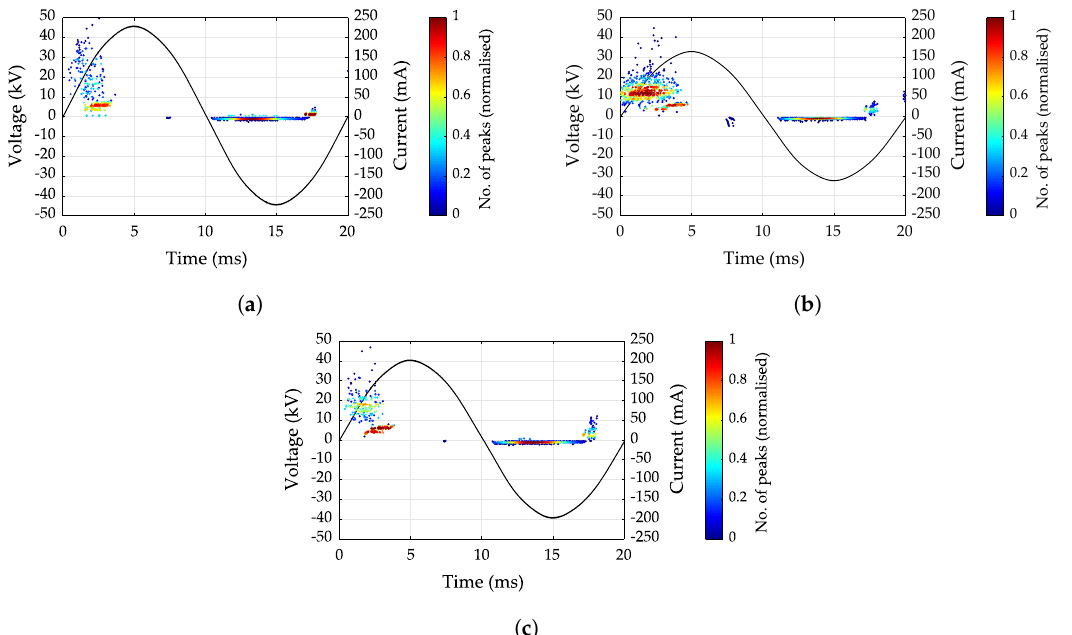
Figure 12. Current peaks densities for 4mm thickness insulator samples in dry air at 1bar absolute pressure: ( a ) PTFE, ( b ) epoxy resin and ( c ) silicone